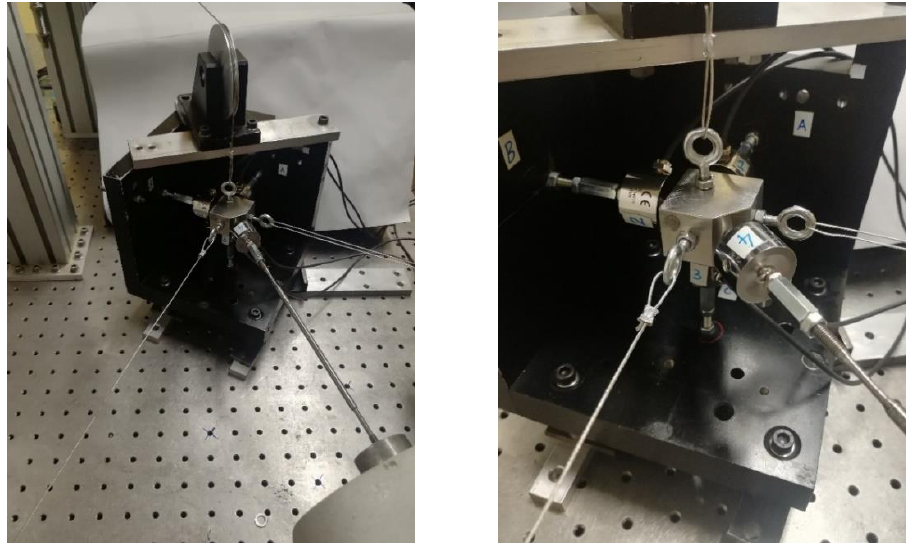
Figure 9. Modified experimental setup for dynamic loading with chamfered block and shaker.